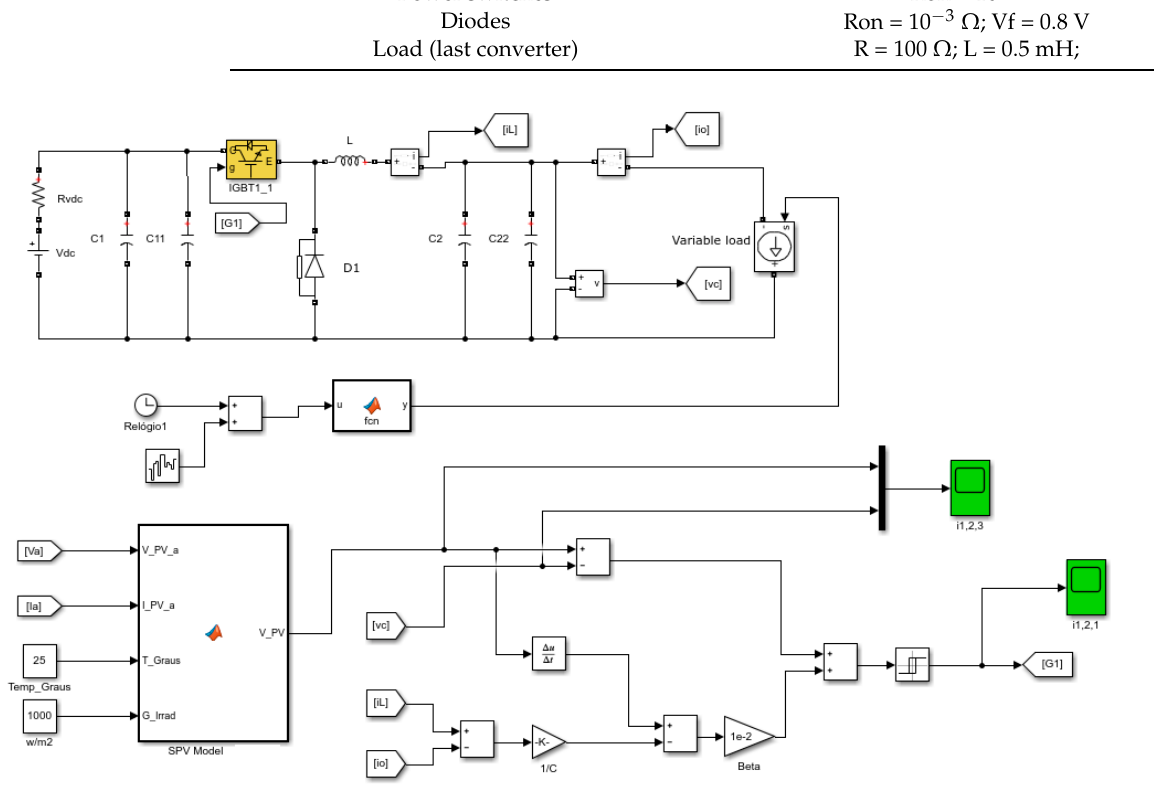
Figure 8. Matlab/Simulink model of the proposed SPV simulator using the buck converter to simulate mode I.